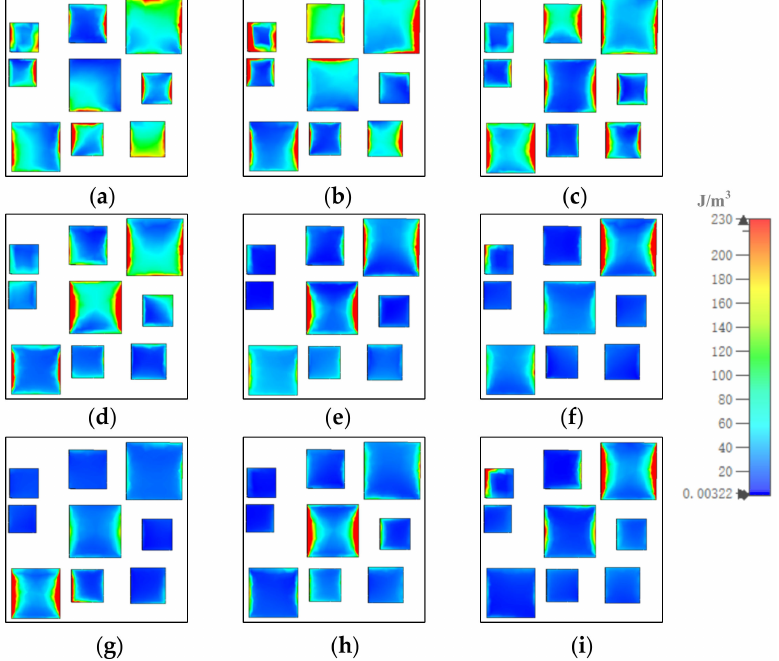
Figure 10. The distribution of magnetic field energy in top gold layer at ( a ) 8.5, ( b ) 9.13, ( c ) 9.88, ( d ) 10.86, ( e ) 11.26, ( f ) 12.07, ( g ) 13.03, ( h ) 13.96, and ( i ) 14.84 µ